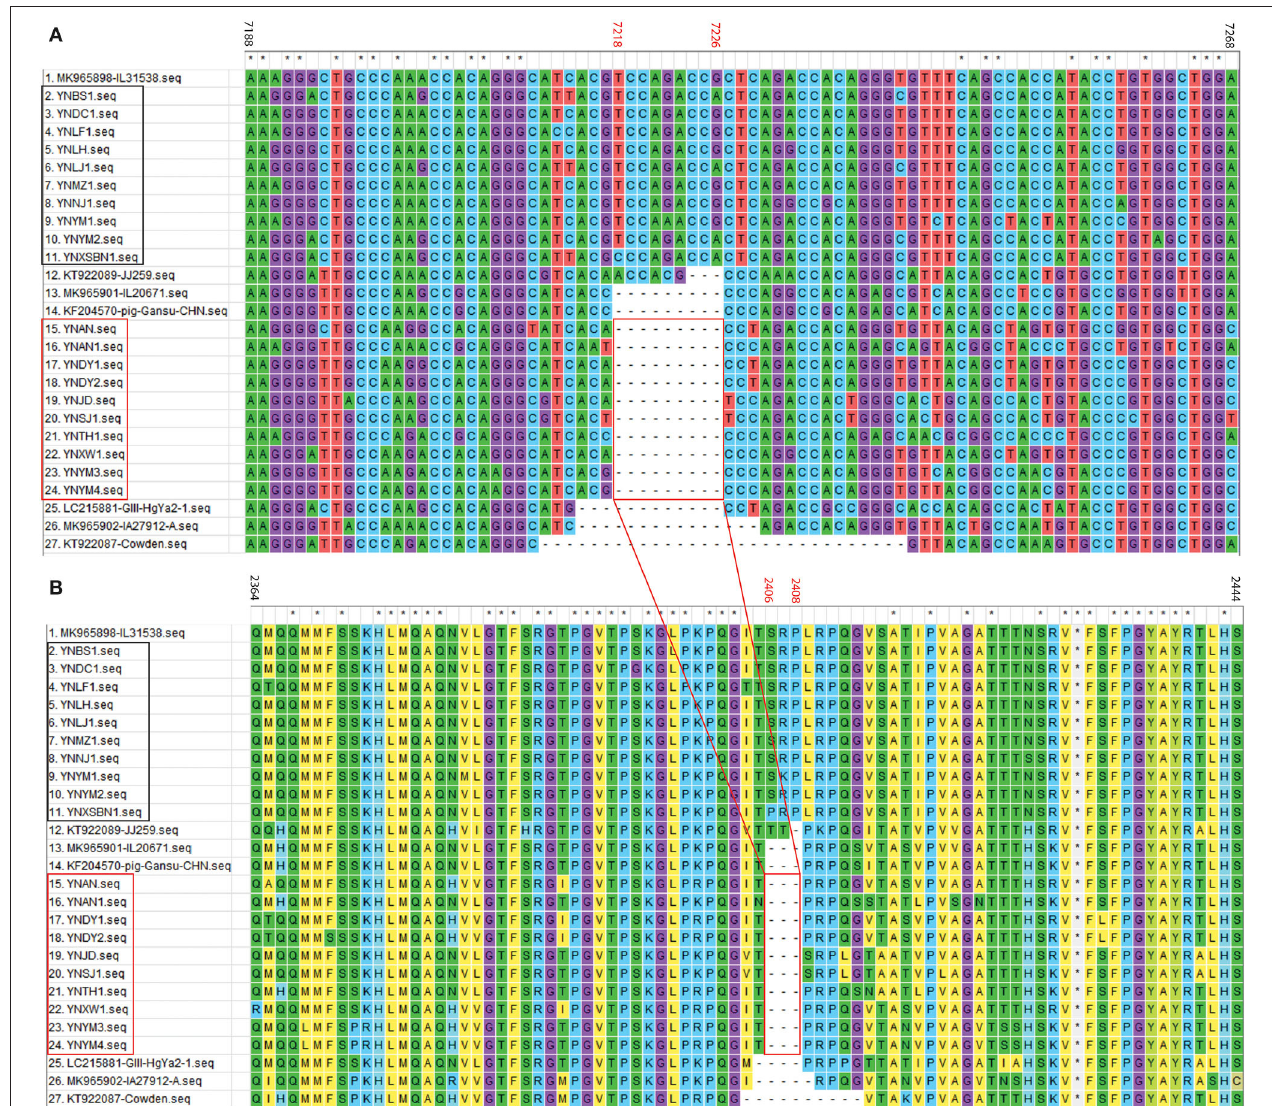
FIGURE 3 | Nucleotide (A) and amino acid (B) sequence alignment of partial VP2 region for PoSaV-GIII strains. ClustalW method with the default parameters was used to perform the similarity analysis of the VP2 gene sequences between the 7 selected PoSaV-GIII VP2 reference sequences ( Supplementary Table S3 ) and the 20 Yunnan PoSaV-GIII VP2 sequences obtained in this study ( Supplementary Table S4 and Supplementary File ). The positions of sequences were provided using MK985898 as reference. The 10 Yunnan PoSaV-GIII VP2 sequences without deletions are indicated with the black square, whereas the other 10 Yunnan PoSaV-GIII VP2 sequences with deletions are indicated with the red square. On top of the aligned sequences, numbers in black stands for the sequence region in comparison, whereas the numbers in red (7218–7226 in A for nucleic acid locations and 2406–2408 in B for the corresponding amino acid locations) indicate the deletion region, which is highlighted by the red squares and the connecting lines. * indicated identical nucleic acid or amino acid sequences across the porcine sapovirus strains.